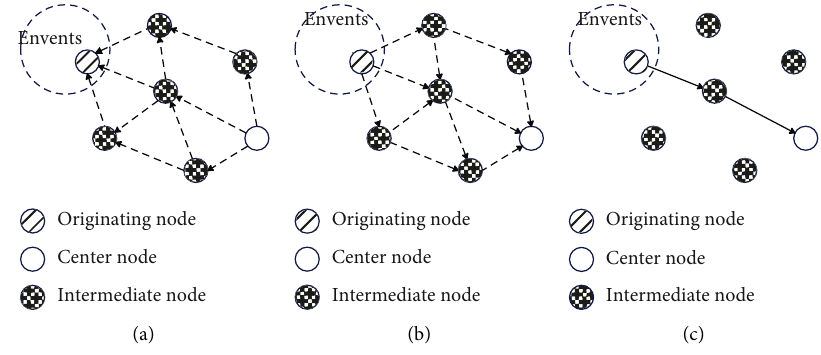
Figure 1: Schematic diagram of directional diffusion.